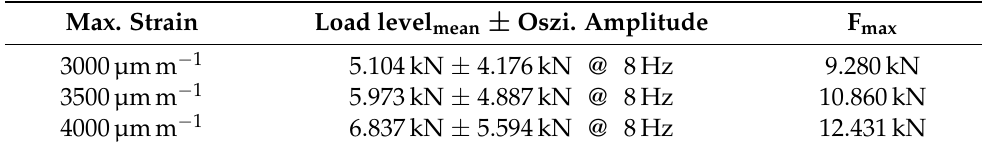
Table 1. Overview of periodic load levels for 1,008,000